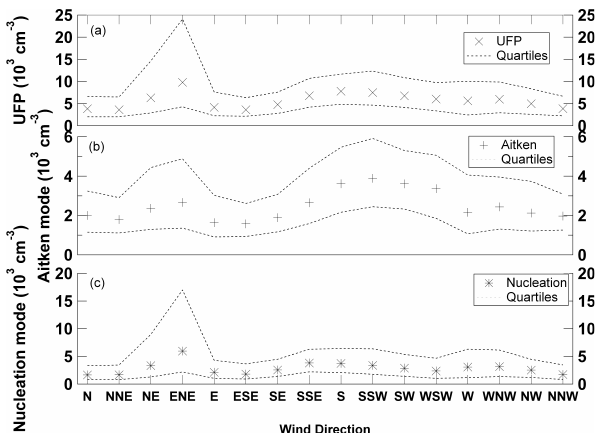
Fig. 6. Number concentration of (a) ultrafine (UFP), (b) Aitken mode and (c) nucleation mode particles and their variation as a func- tion of wind direction. The median number concentrations and the 1st and 3rd quartiles are presented.